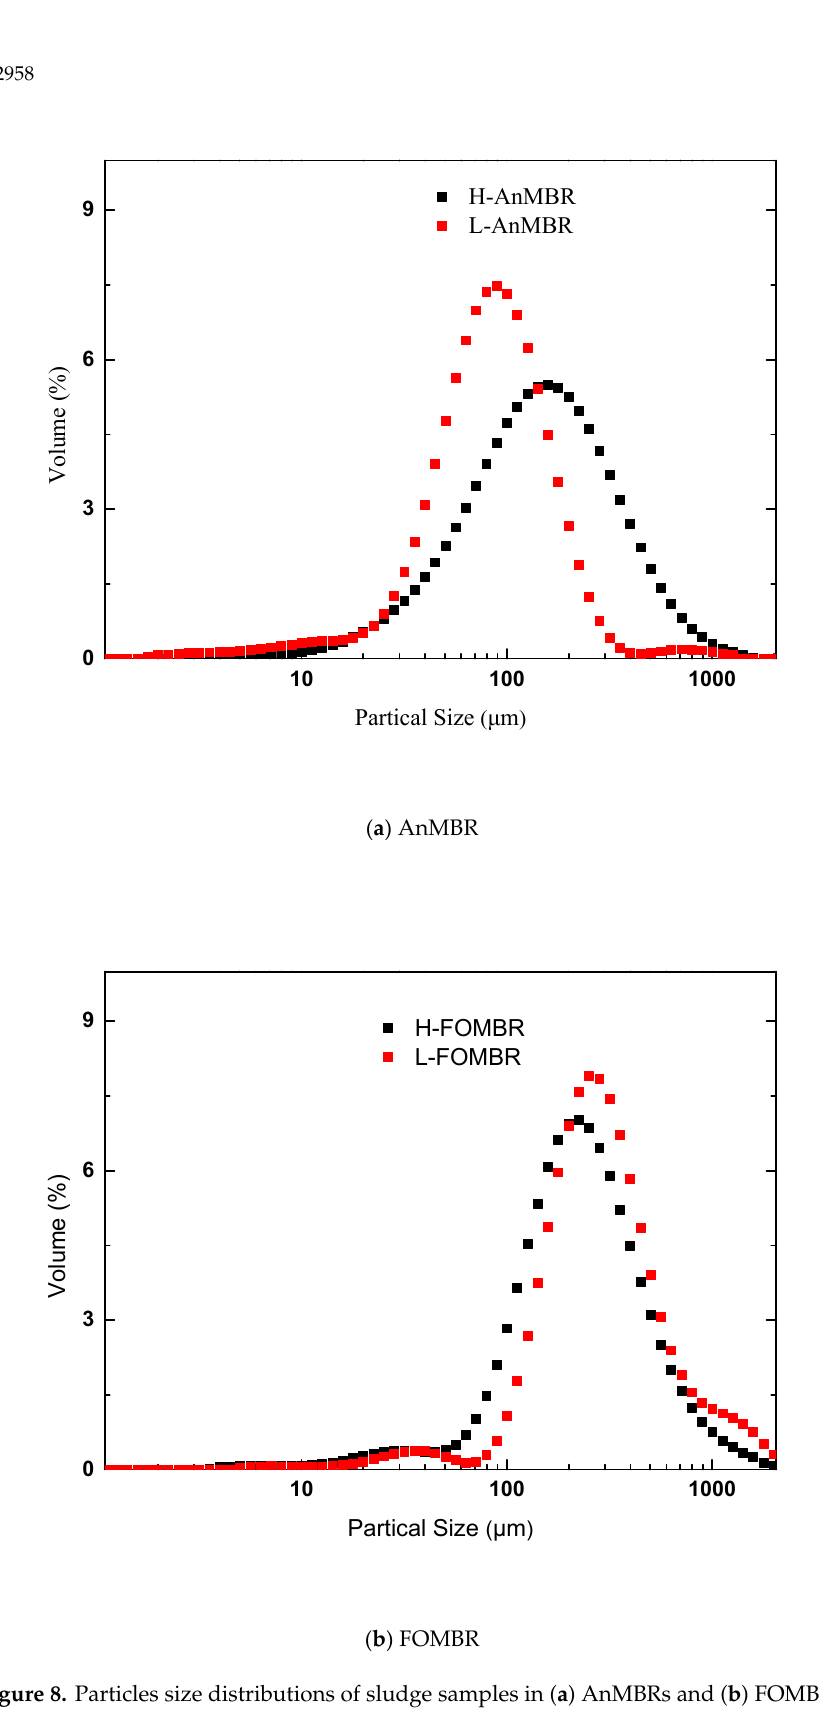
Figure 8. Particles size distributions of sludge samples in ( a ) AnMBRs and ( b ) FOMBRs.